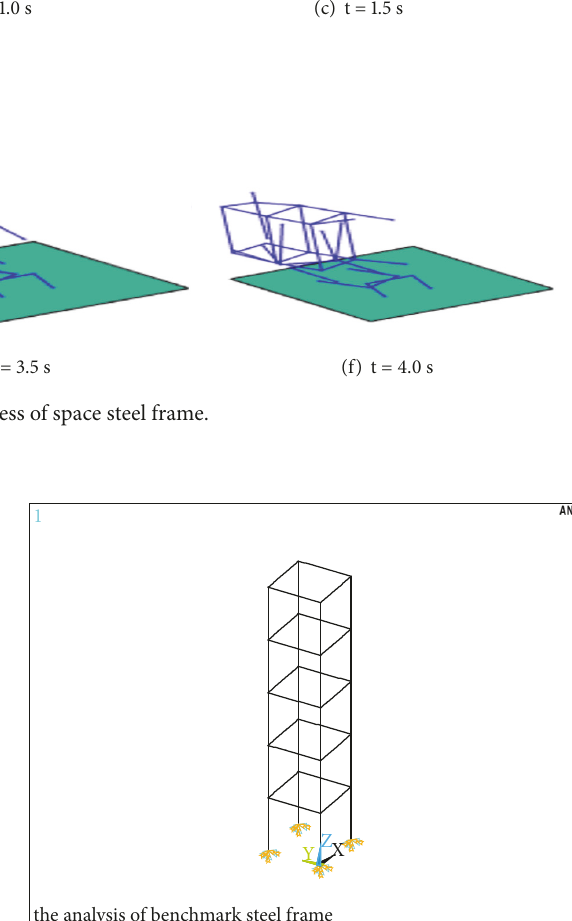
Figure 23: Finite element model